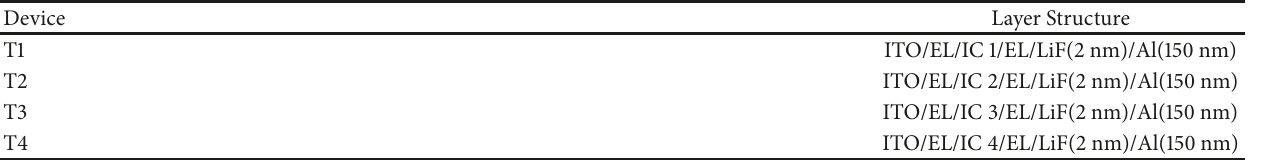
Table 3: Detailed layer structures of red tandem OLED with different interconnectors.